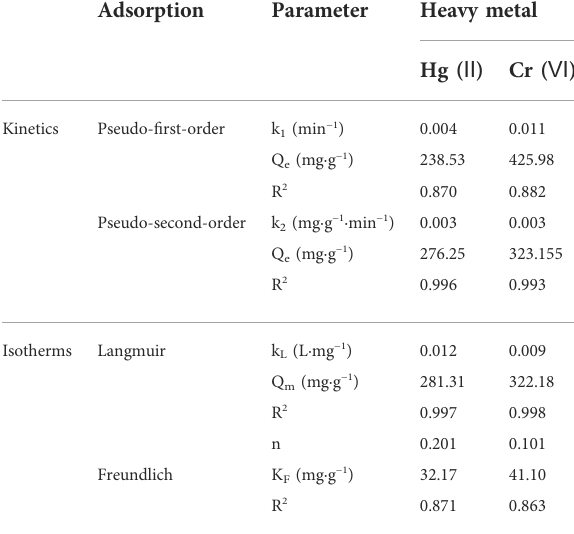
ratios as HCSS2 (SD:SS = 1:2), HCSS (SD:SS = 1:1), and HCSS0.5 (SD:SS = 2:1). As shown in Supplementary Figure S2, the capacity increased from 66.98 mg/g and of HCSS2 to 75.12 mg/g of HCSS